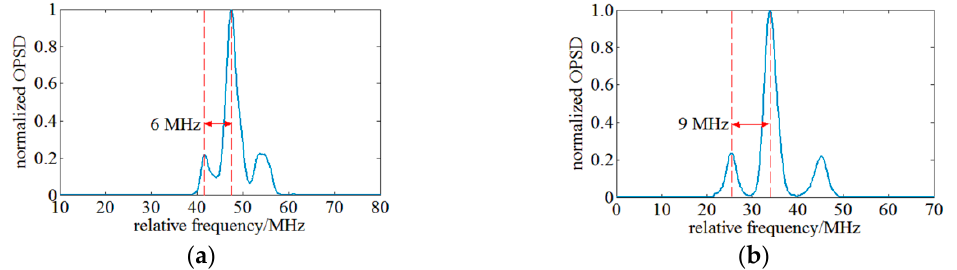
Figure 9. ( a ) OSA of 6 MHz frequency interval spectrum signal; ( b ) OSA of 9 MHz frequency interval spectrum signal.